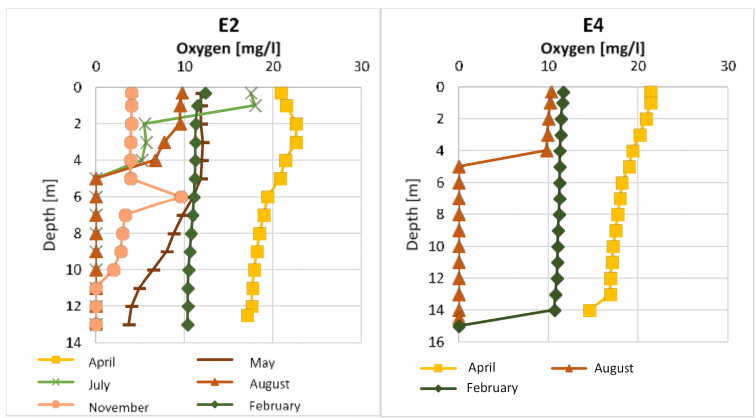
Figure 4. Oxygen distribution in the water column of Lake Eichbaumsee at locations E2 and E4 between April 2018 and February